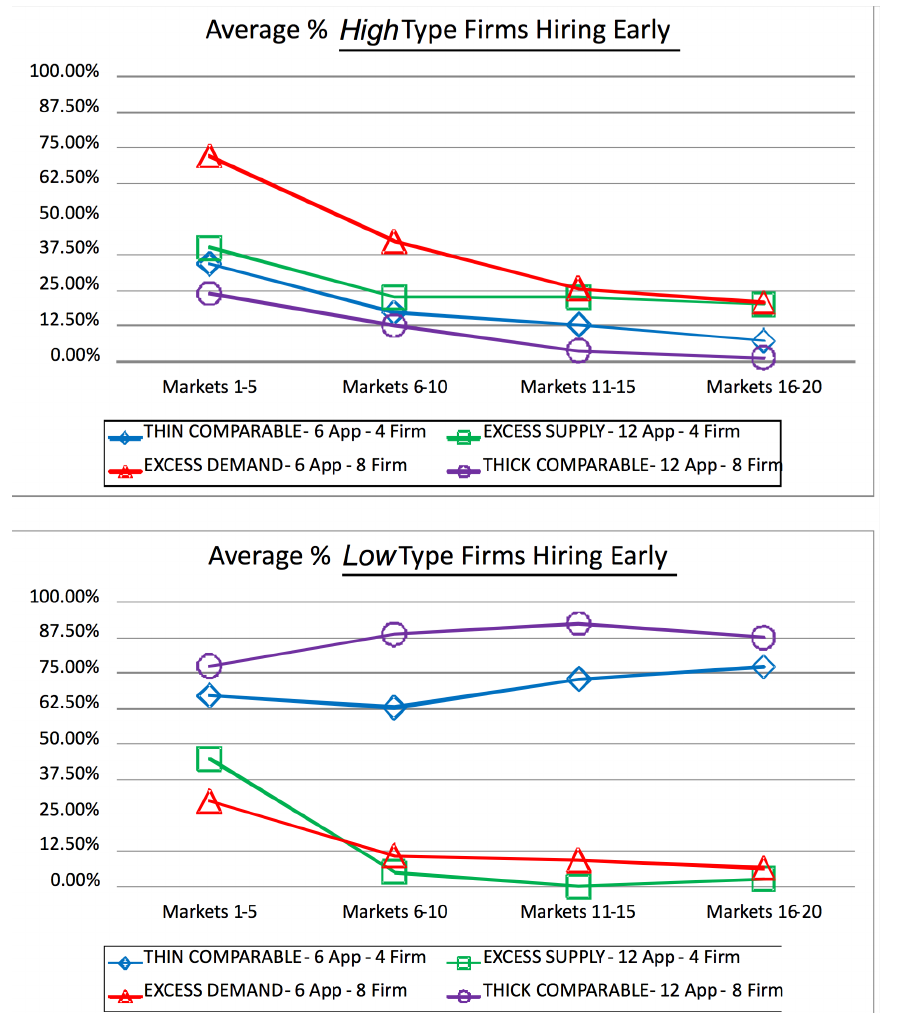
Figure 3. Average percentage of high and low type firms hiring early across